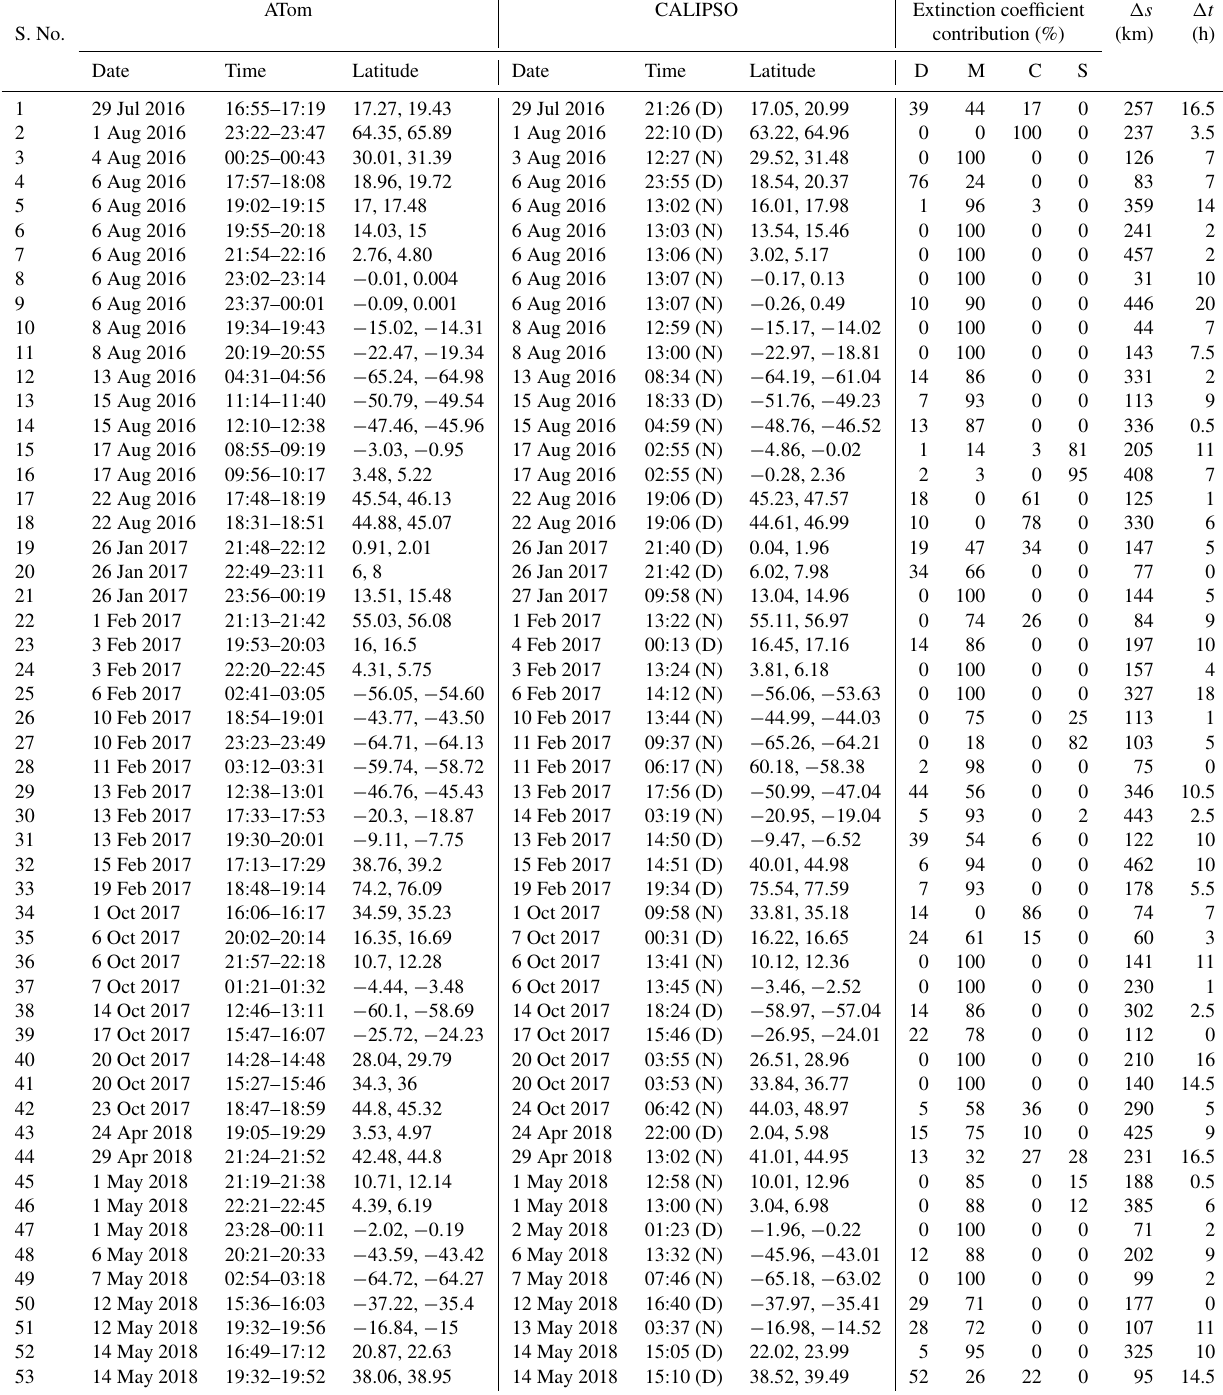
Table A1. Details of ATom and CALIPSO data for the identified intersections. (cid:49)t is the effective time difference between the tracks after incorporating HYSPLIT trajectories. The difference in distance ( (cid:49)s ) and (cid:49)t between the measurements are averaged values. Note: D – dust; M – marine; C – polluted continental; S – elevated smoke.